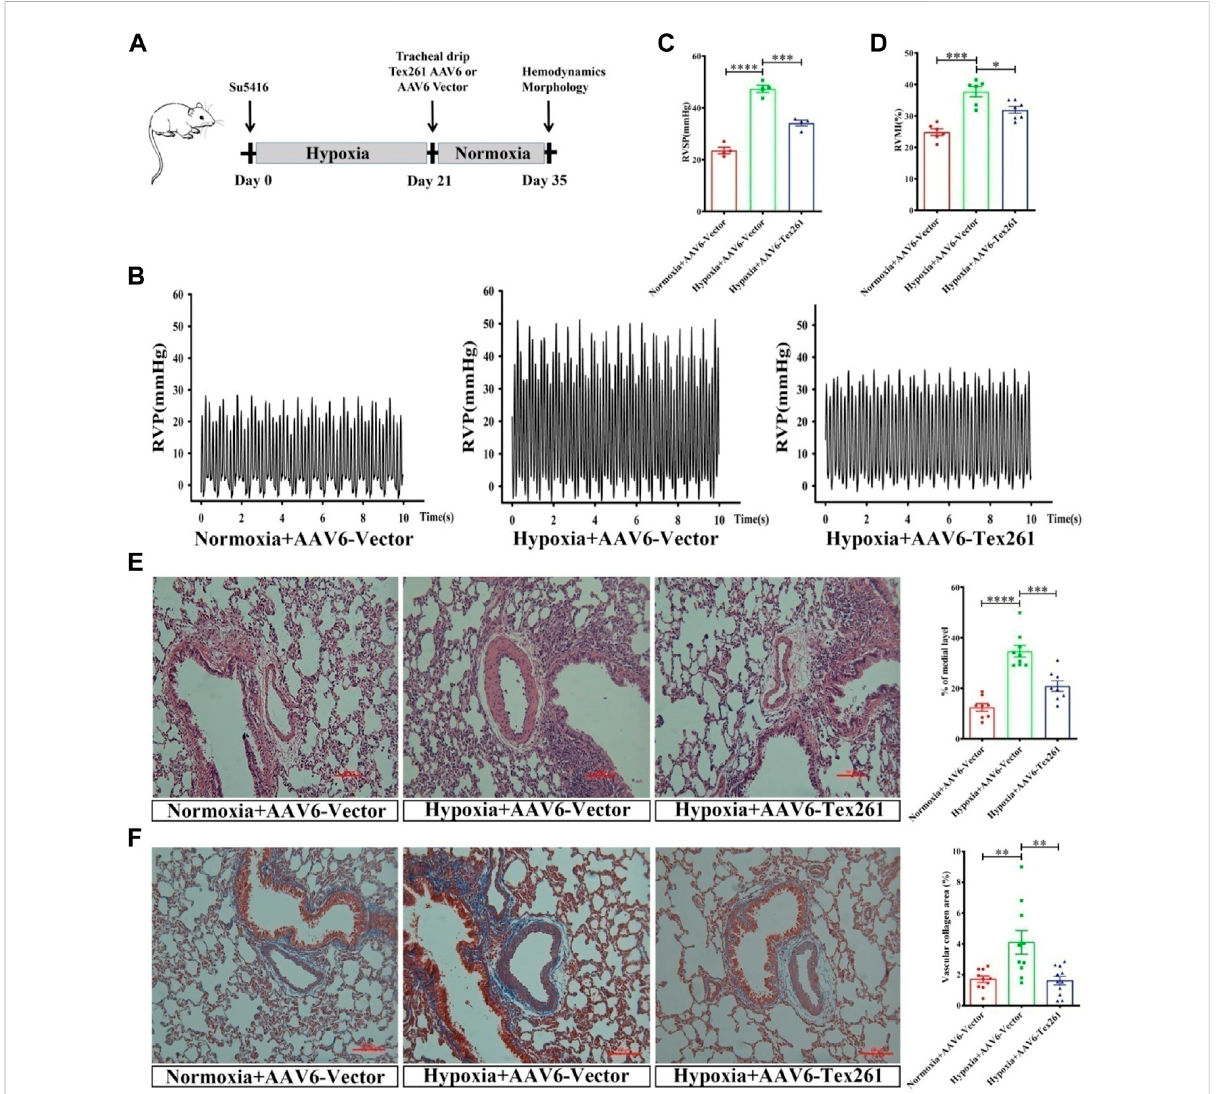
FIGURE 7 The therapeutic effect of Tex261 on rats with PAH. (A) Animal treatment protocols for the therapeutic effect of Tex261. After administration of Su5416, rats were exposed to hypoxia for 3 W to establish a PAH model, and then, AAV6 was injected and the animals were fed for 2 W. Hemodynamics and morphology were recorded. (B – D) Representative tracings of RVP, RVSP and RVMI recorded from the control + AAV6-GFP, hypoxia+AAV6-GFP,andhypoxia+AAV6-Tex261-GFPmice. (E) PARwasobservedbyHEstainingandobservedbya×20microscopy.ThePAR was calculated according to the average of the four diagonal thicknesses divided by the diameter of the vessel. (F) Vascular fi brosis was detected by Massonstainingandobservedby×20microscopy.Dataarepresentedasthemean±SEM. n =4 – 6,* p < 0.05,** p < 0.01and*** p < 0.001vs.hypoxia +